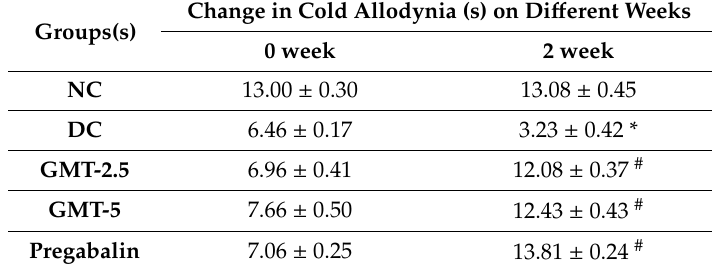
Table 4. E ff ect of chloroform extract of goat milk treated A. napellus on cold allodynia assessed by tail immersion (cold water)